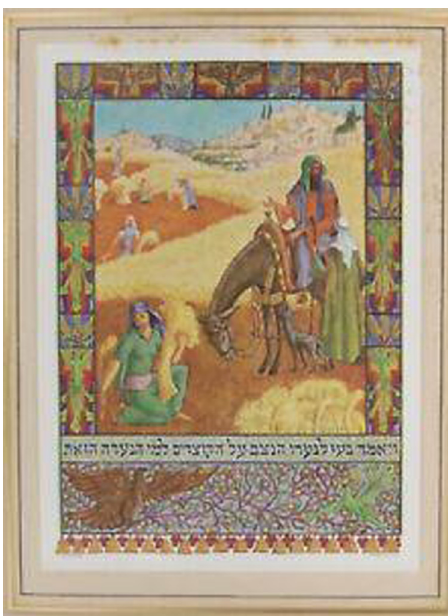
Figure 8: Ze ’ ev Raban, “ Boaz and Ruth, ” 1930.